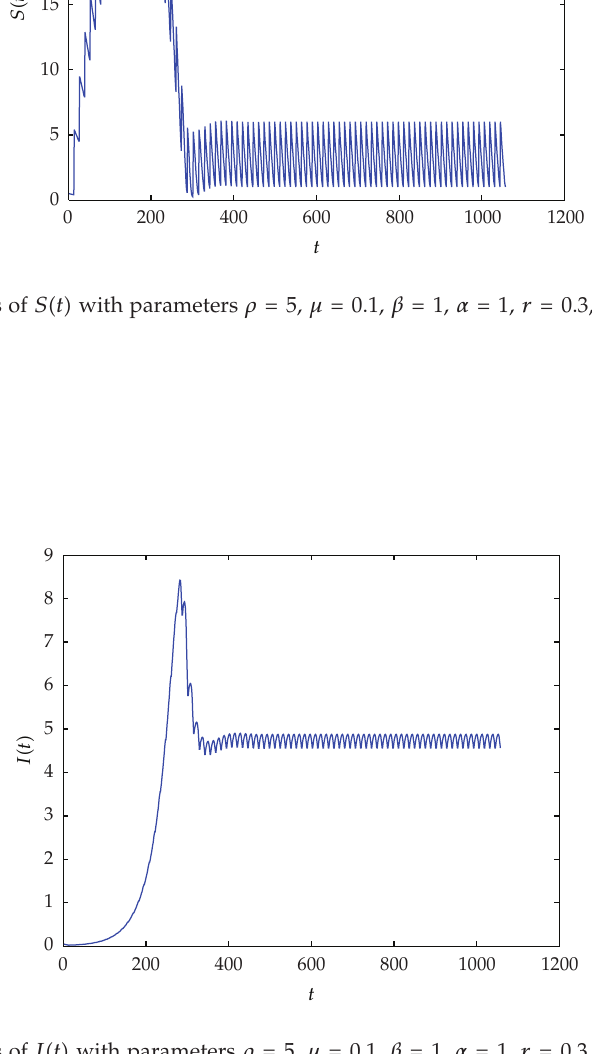
Figure 17: Time series of I (cid:3) t (cid:4) with parameters ρ (cid:7) 5 , μ (cid:7) 0 . 1 , β (cid:7) 1 , α (cid:7) 1 , r (cid:7) 0 . 3 , d (cid:7) 0 . 2 , ω (cid:7) 0 . 2 , T (cid:7) 0 . 8 , and τ (cid:7) 0 .